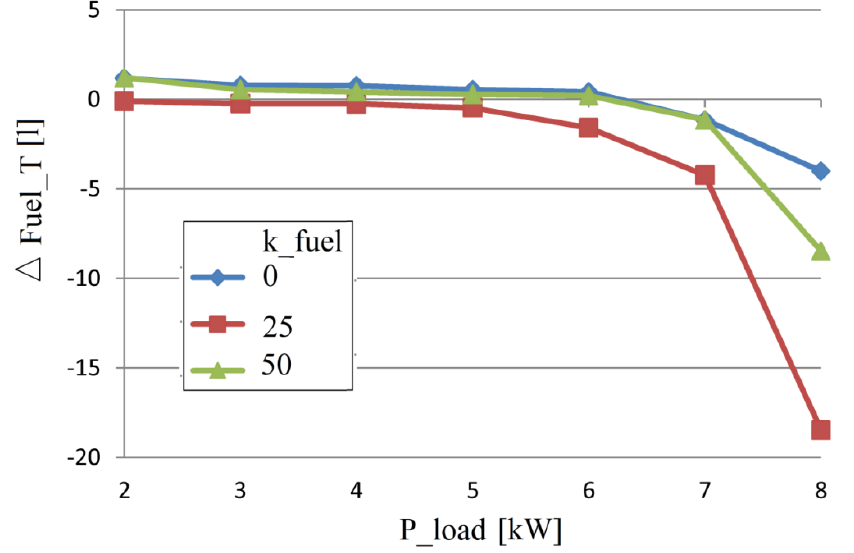
Figure 8. The values of the fuel economy, in the all situation, for the RTO2 strategy: A ( k fuel = 0), B ( k fuel = 25), and C ( k fuel = 50) under constant load.